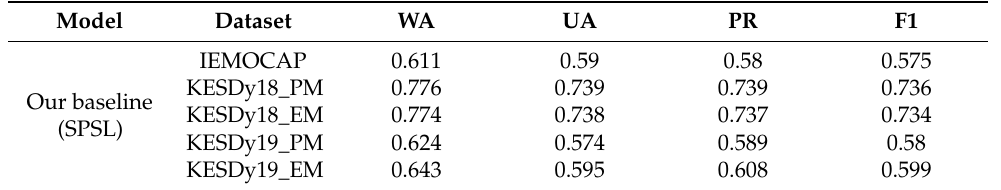
Table 4. Performance of the baseline BLSTM-based SER